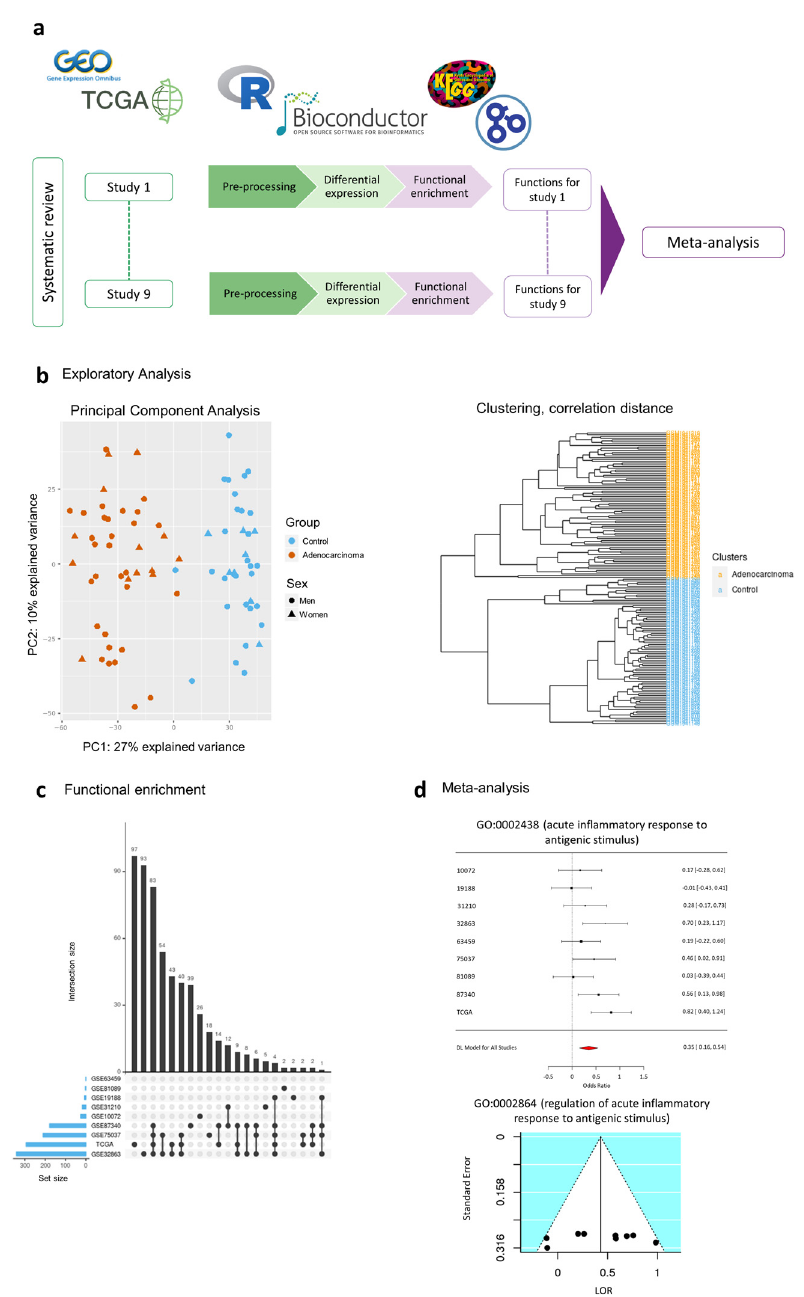
Figure 5. Workflow and analysis design. ( a ) Summary of the analysis design followed in this work, ( b ) PCA plot and HC analysis as an example of exploratory analysis (to explore possible batch effects and to assure expected data behavior) performed at the pre-processing stage to assess for the integrity of the data, ( c ) example of UpSet plot as an intersection analysis for functional enrichment analysis results, and ( d ) examples of forest and funnel plots to assess meta-analysis results.